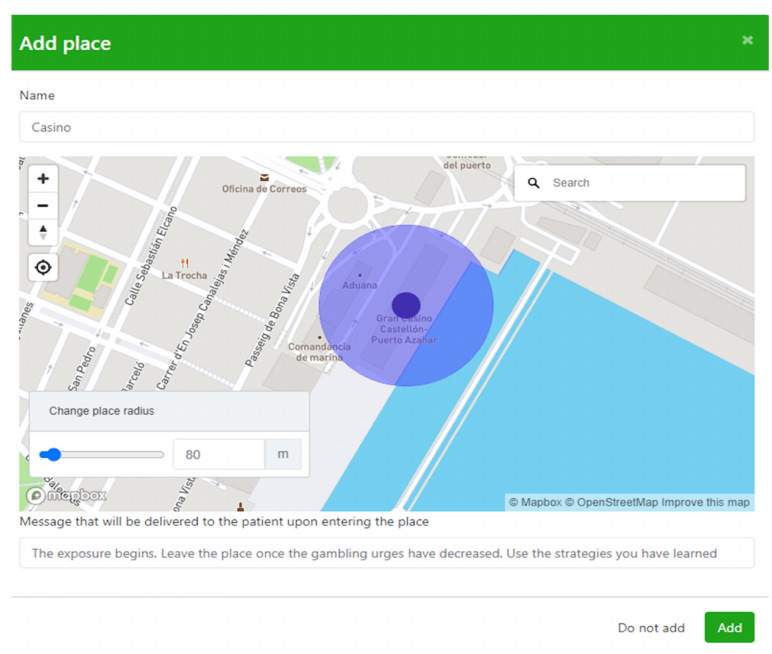
Figure 2. Smartphone app configuration during the ERP therapeutic